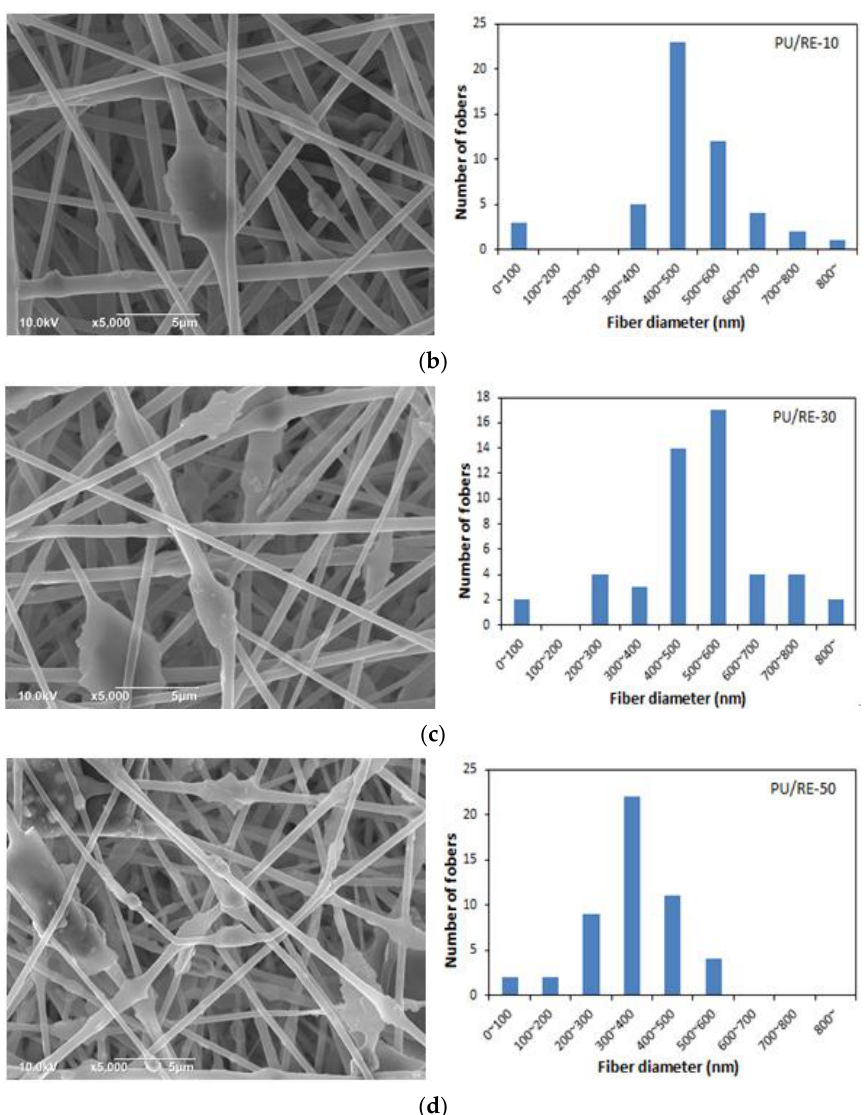
Figure 3. FE-SEM images and diameter distributions of ( a ) polyurethane (PU); ( b ) PU/RE-10; ( c ) PU/RE-30 and ( d ) PU/RE-50.